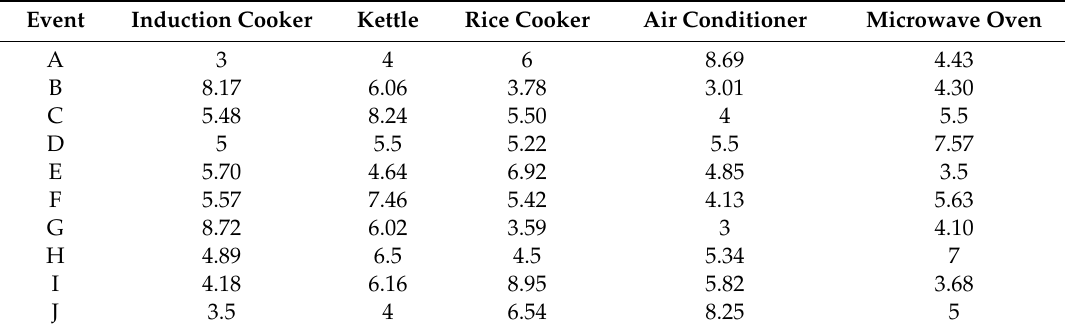
Table 7. The value of 2-D fuzzy membership about each event.